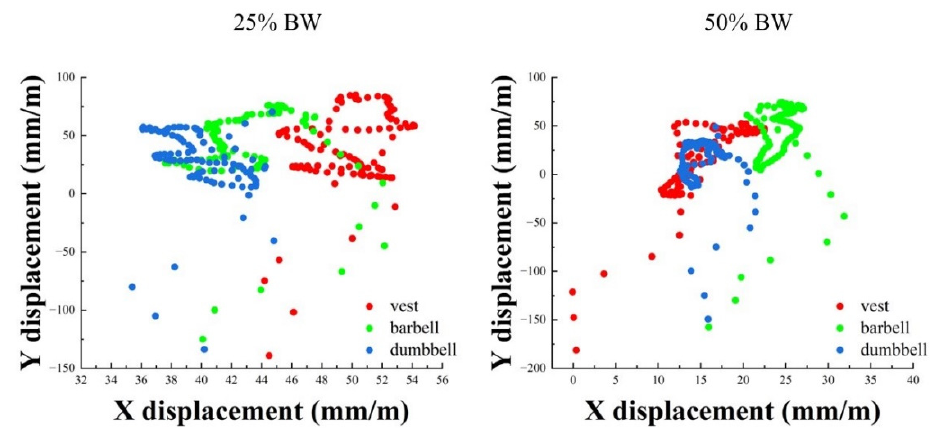
Figure 4. COP motion trajectory at 25% BW and 50% BW. BW: body weight. Table 3. COP x-axis offset range and y-axis offset at 25% BW and 50% BW.